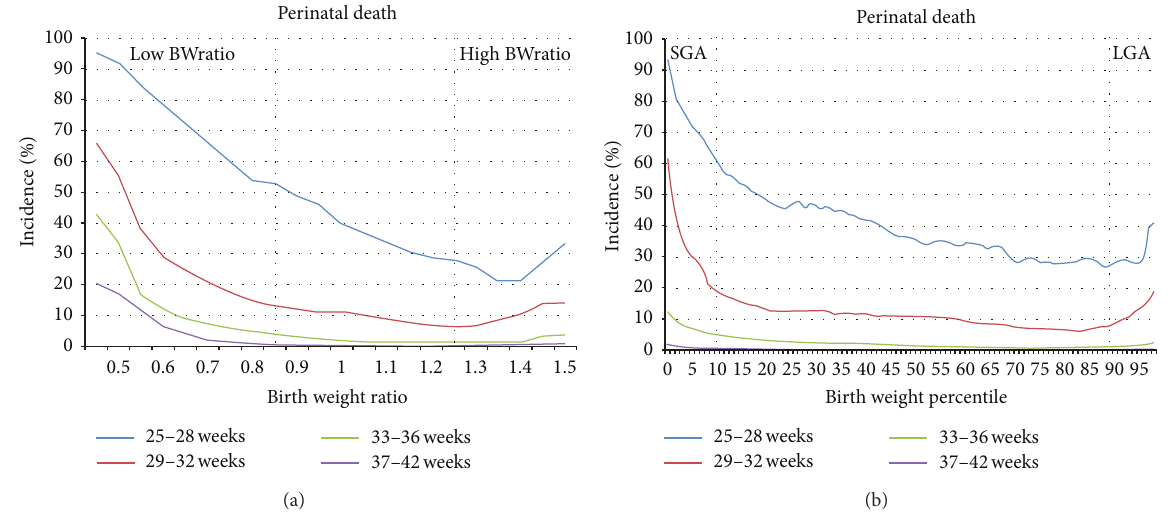
Figure 2: Incidences of perinatal death stratified by gestational age at delivery separate for birth weight ratio (a) and birth weight percentiles